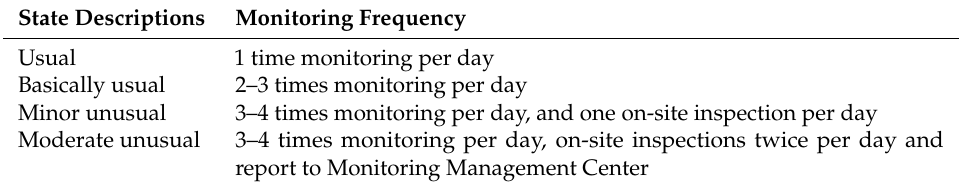
Table 3. Management of monitoring